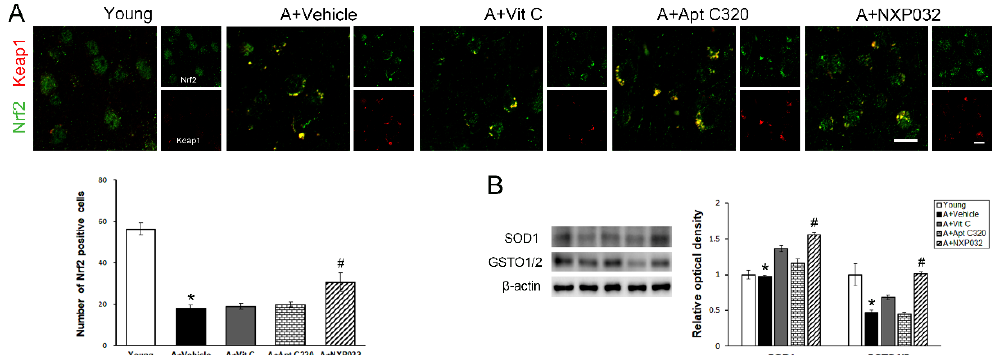
Figure 7. Effect of NXP032 on aging-induced Nrf2 dysfunction in the brain. ( A ) Representative photographs of immunofluorescence staining of Nrf2 (green) and Keap1 (red) in the brain. The aging mice had a significantly reduced number of Nrf2 in the brain. NXP032-treated mice had a significantly higher Nrf2 in the brain than in the vehicle-treated mice. In the vit C and Aptamin 320-treated groups, the number of Nrf2 did not increase in the brain. ( B ) Representative bands of SOD-1 and GSTO1/2 protein expression in the hippocampus. The aging mice had significantly reduced SOD-1 and GSTO1/2 protein expression in the hippocampus. NXP032-treated mice had a significantly higher SOD-1 and GSTO1/2 expression in the hippocampus than in the vehicle-treated mice. In the vit C and Aptamin 320-treated groups, the expression of SOD-1 and GSTO1/2 did not increase in the hippocampus. The data are presented as the mean ± S.E.M. * p < 0.05, compared to the young group. # p < 0.05, compared to the aging-vehicle group. Scale bar: 20 µ